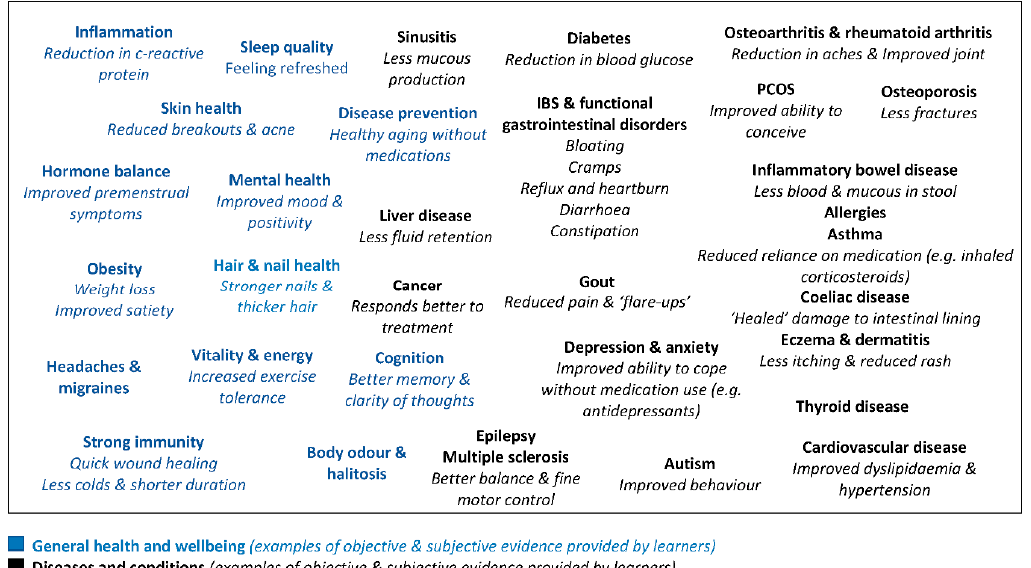
Figure 3. Summary of perceived benefits to following an anti-inflammatory diet reported by learners.